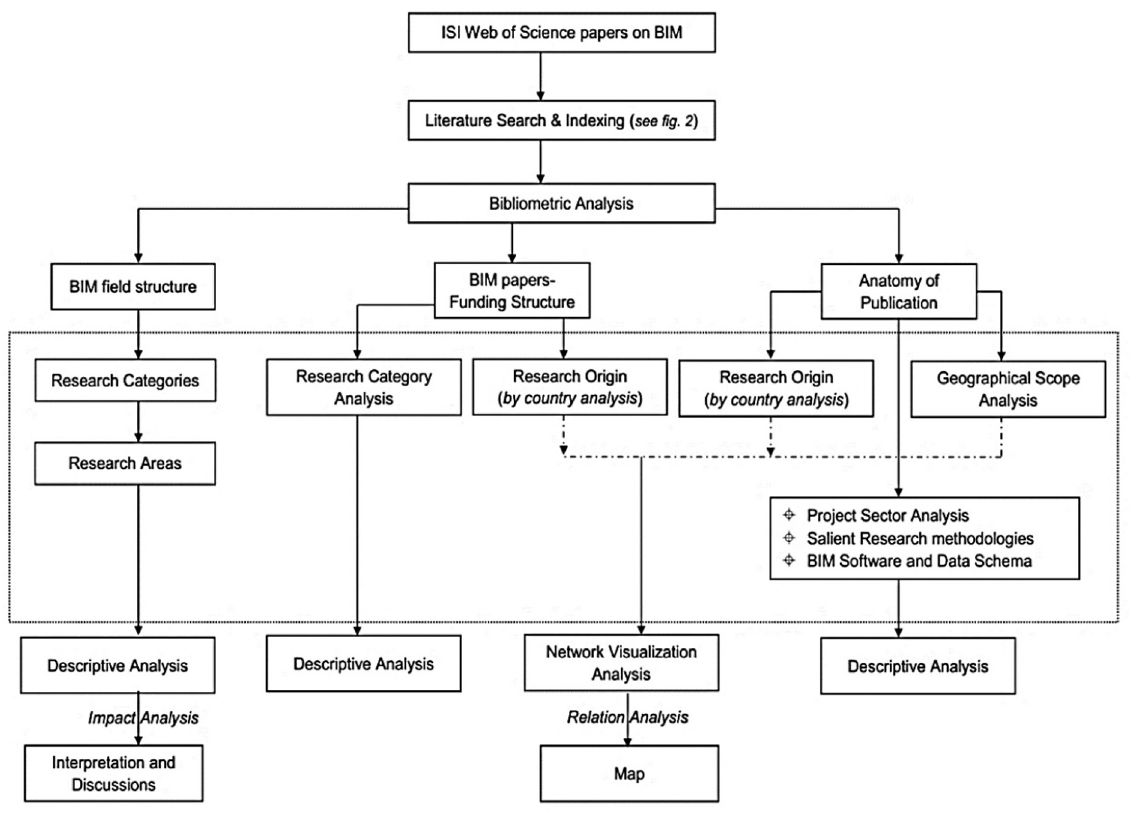
Fig. 1. Outline of research